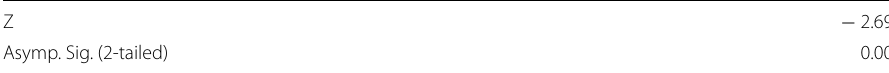
Table 7 Wilcoxon signed-rank test statistic, virtual study group-online course Z